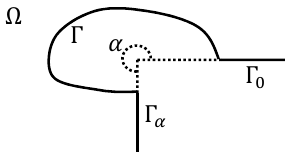
Figure 1. The illustration of domain Ω .